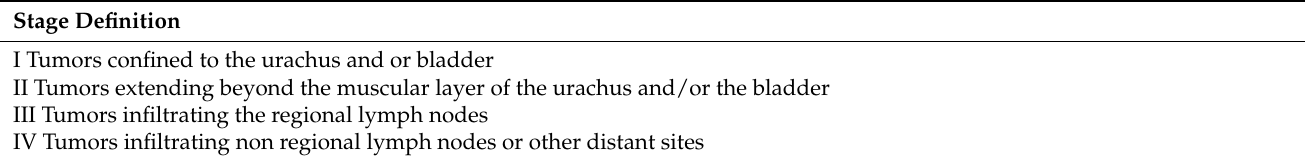
Table 3. Urachal cancer staging system as defined by the Mayo Clinic